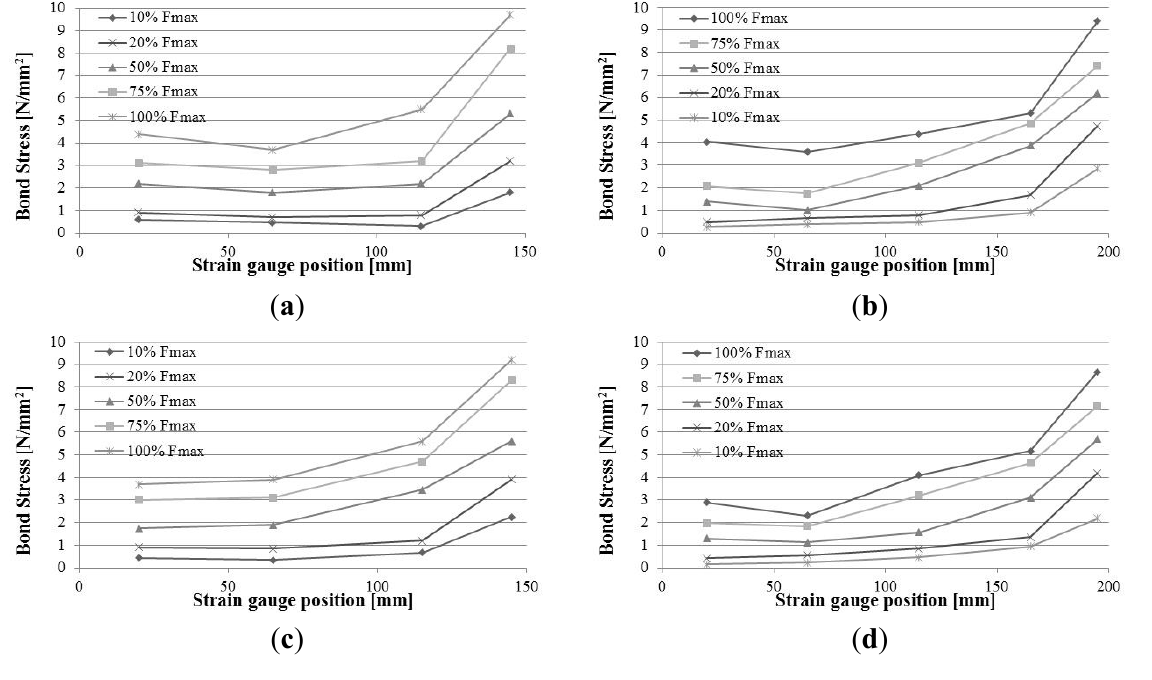
Figure 13. Bond stress versus position: ( a ) SF_2 test; ( b ) SF_4 test; ( c ) SC_2 test; ( d )